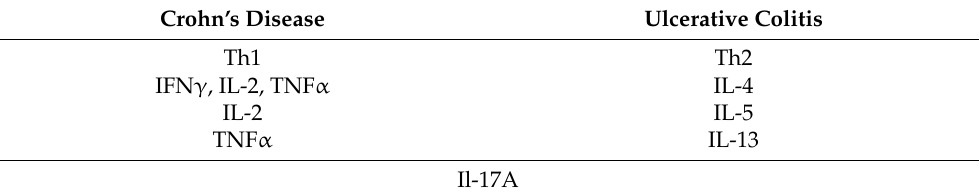
Table 2. Immunological factors associated with Crohn’s disease and ulcerative